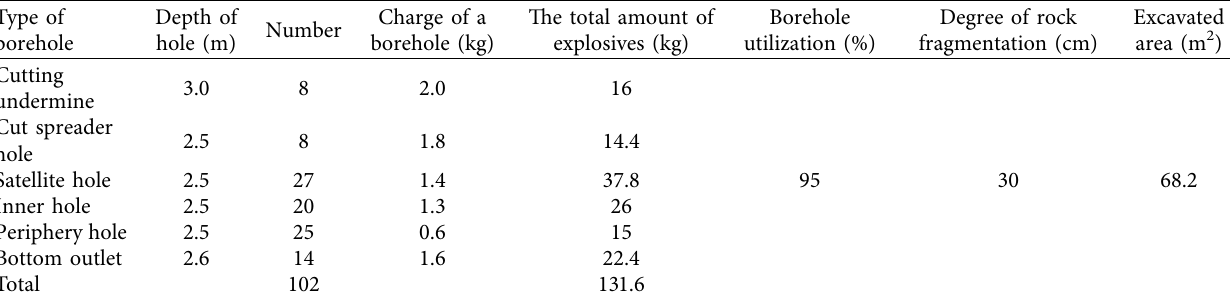
Table 6: Design parameters of shaped blasting.